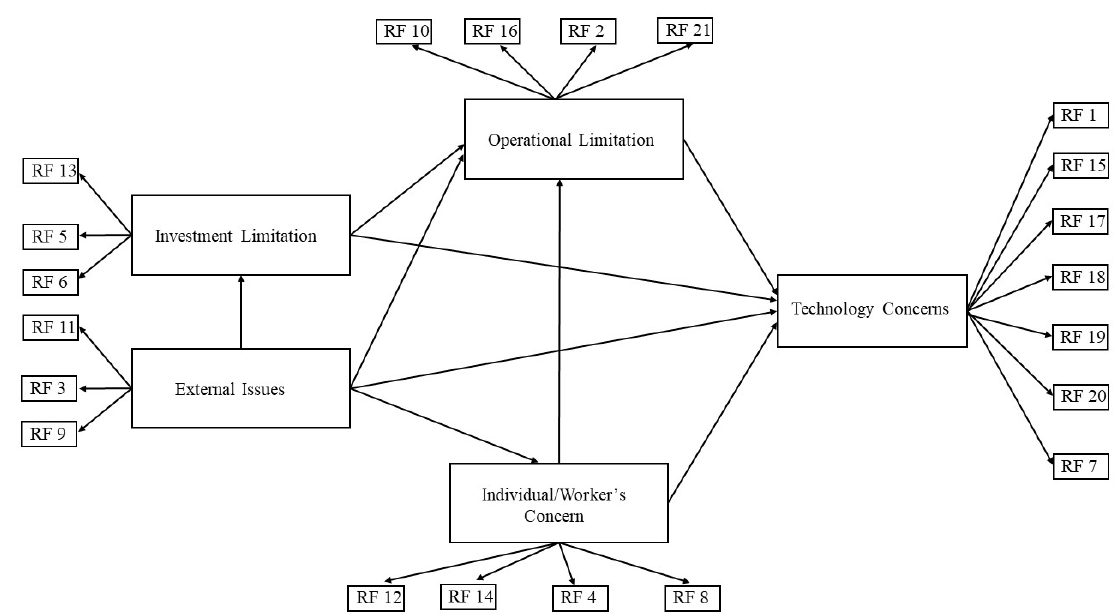
Figure 2. Initial conceptual model highlighting the networking of risk criticality paths in ImT im-